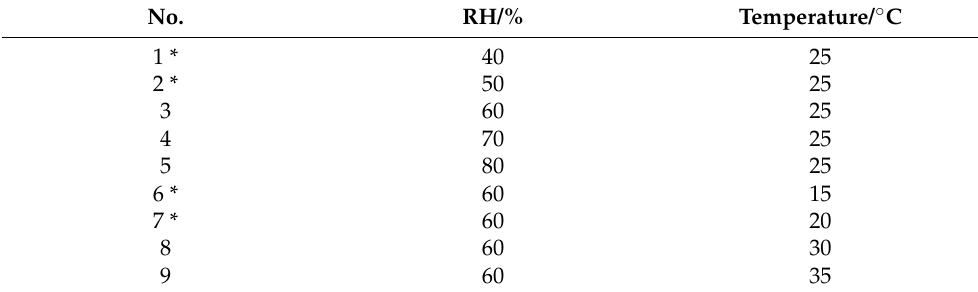
Table 1. Single-factor test scheme. No. RH/% Temperature/ ◦